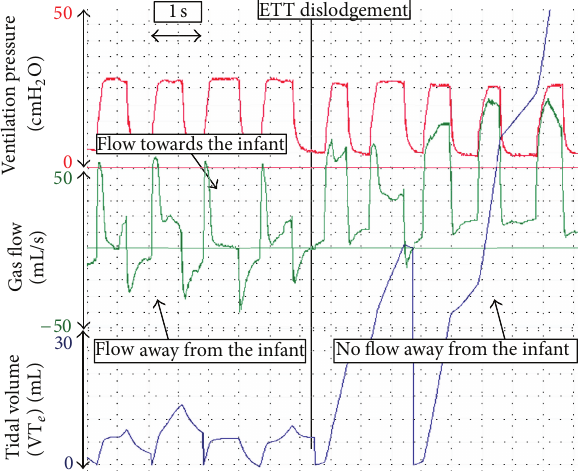
Figure 4: During PPV, the ETT suddenly becomes dislodged.